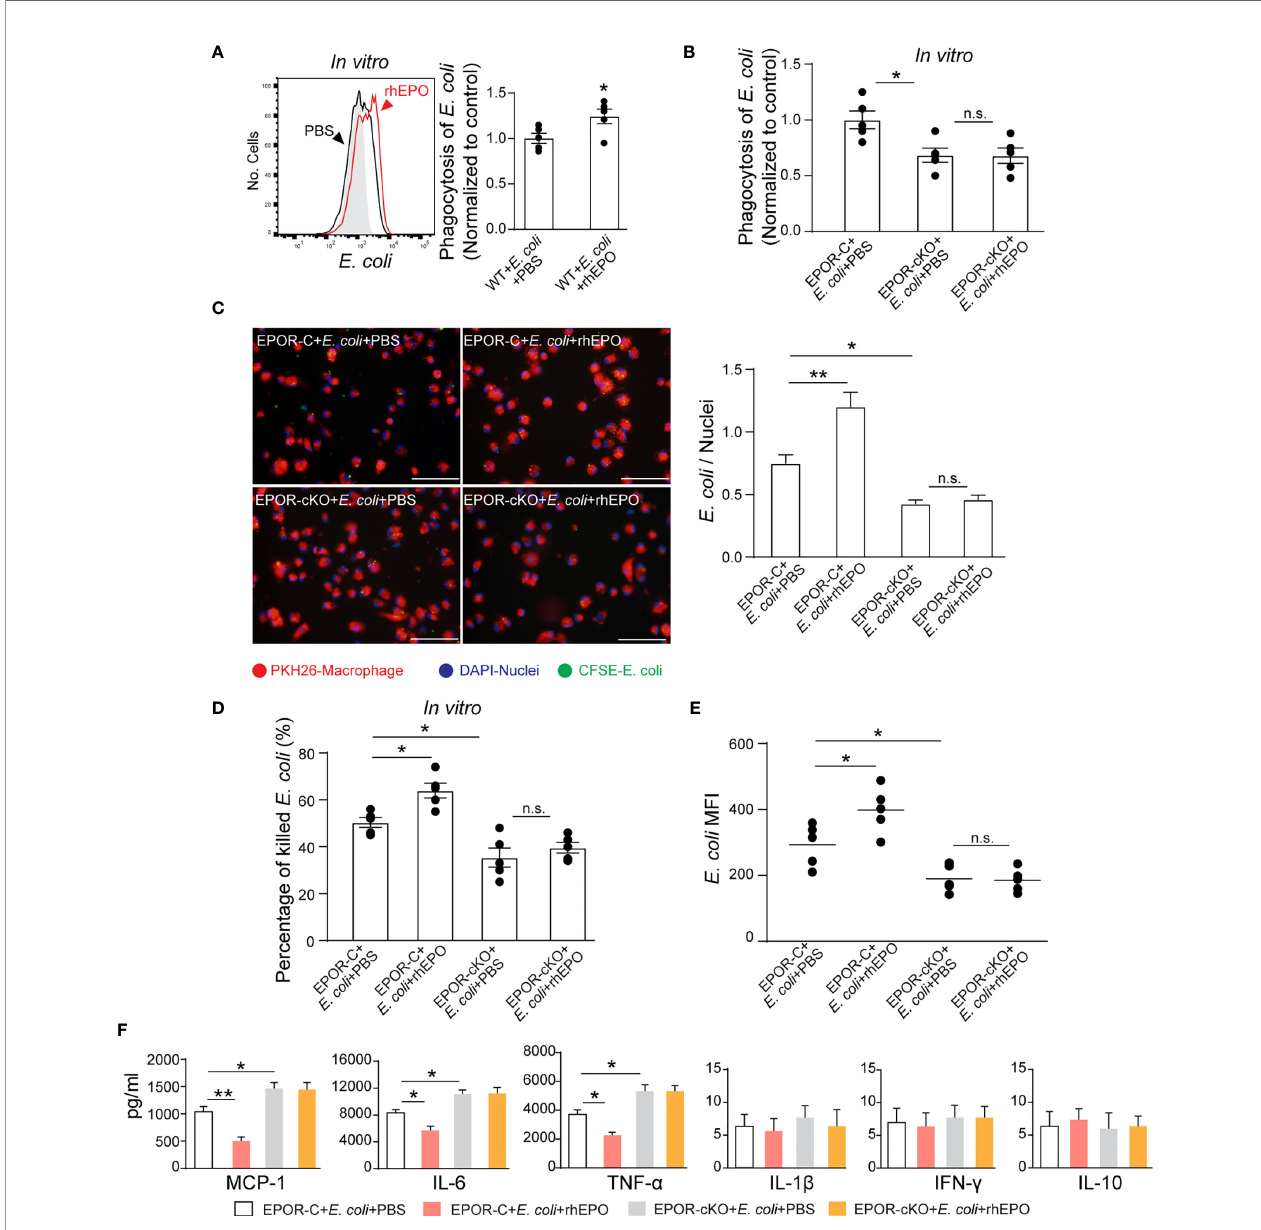
FIGURE 3 | EPO enhances macrophage clearance of E. coli in vitro and in vivo . (A) : In vitro cultured WT mice thioglycolate-elicited peritoneal macrophages were pretreated with rhEPO (20 IU/ml) or PBS for 24 hrs, cells were then collected and incubated with fl uorescently labeled E. coli for 30 min (macrophage: E. coli = 1: 10) at 37°C or 4°C (Gray, non- phagocytosis control), phagocytosis was analyzed by fl ow cytometry (n = 5). Statistical graph depicts the increase in MFI; phagocytosis by PBS-treated cells was normalized and used as a control. (B) : Thioglycolate-elicited peritoneal macrophages from EPOR-C or EPOR-cKO mice were pretreated with rhEPO (20 IU/ml) or PBS for 24 hrs. Cells were then collected and incubated with fl uorescently labeled E. coli for 30 min (macrophage: E. coli = 1: 10), phagocytosis of E. coli was assayed by fl ow cytometry (n = 5). Phagocytosis by EPOR-C cells was normalized to control. (C) : Thioglycolate-elicited peritoneal macrophages from EPOR-C or EPOR-cKO mice were treated with rhEPO (20 IU/ml) or PBS for 24 hrs and then seeded with fl uorescently labeled E. coli (macrophage: E. coli = 1: 10) for 30 min, uptake of E. coli was detected by microscopy (Bars, 50 m M). Statistical graph represents quanti fi cation of engulfed E. coli (n = 5). (D) : Thioglycolate-elicited peritoneal macrophages from EPOR-C or EPOR-cKO mice were cultured with rhEPO (20 IU/ml) or PBS for 24 hrs and then incubated with E. coli (macrophage: E. coli = 1: 10) for indicated times. In vitro bacterial killing activities of macrophages were performed (n = 5) as described in Materials and Methods. (E) : EPOR-C and EPOR-cKO mice were intraperitoneally inoculated with E. coli at 1 × 10 5 c.f.u. together with rhEPO (5,000 IU/kg) or PBS by intraperitoneal injection. After 24 hrs, exudate leukocytes were lavaged and intracellular E. coli levels in macrophages were analyzed by fl ow cytometry (n = 5). (F) : In vitro cultured EPOR-C and EPOR-cKO mice thioglycolate-elicited peritoneal macrophages were stimulated with rhEPO (20 IU/ml) or PBS plus heat deactivated E. coli (macrophage: E. coli = 1: 10) for 24 hrs, in fl ammatory cytokines in medium supernatant were assayed (n = 3). Data are representative of at least two independent experiments. Results were expressed as mean ± SEM. ns, not statistically signi fi cant. * P < 0.05, ** P < 0.01. Statistics: unpaired two-tailed Student ’ s t-test (A) or one-way ANOVA with Tukey ’ s post hoc test for multiple comparisons (B – F) . MFI, mean fl uorescence